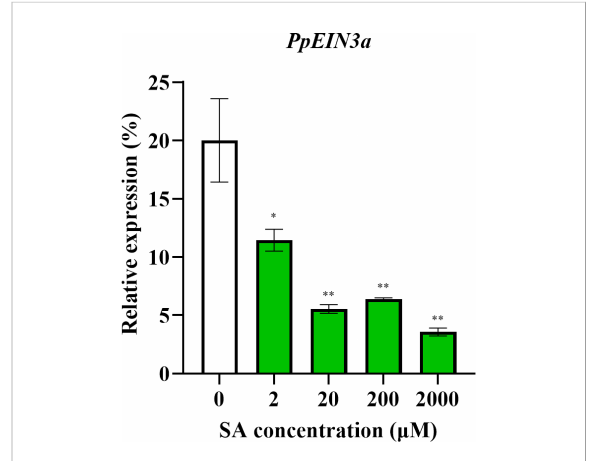
FIGURE 4 Real-time quantitative PCR analyses of the PpEIN3a expressions in the pulp of fruit under SA treatment for 12 h. The relative PpEIN3a expression values in pulp one week after fruit harvest that were treated with 0, 2, 20, 200, and 2000 m M SA for 12 h are shown as percentages of actin expression. The mean values and standard errors (bar) shown are from three independent experiments. Independent t tests for equality of means demonstrated signi fi cant (* p value < 0.05) or very signi fi cant (** p value < 0.01) differences between the control and treated pulp of